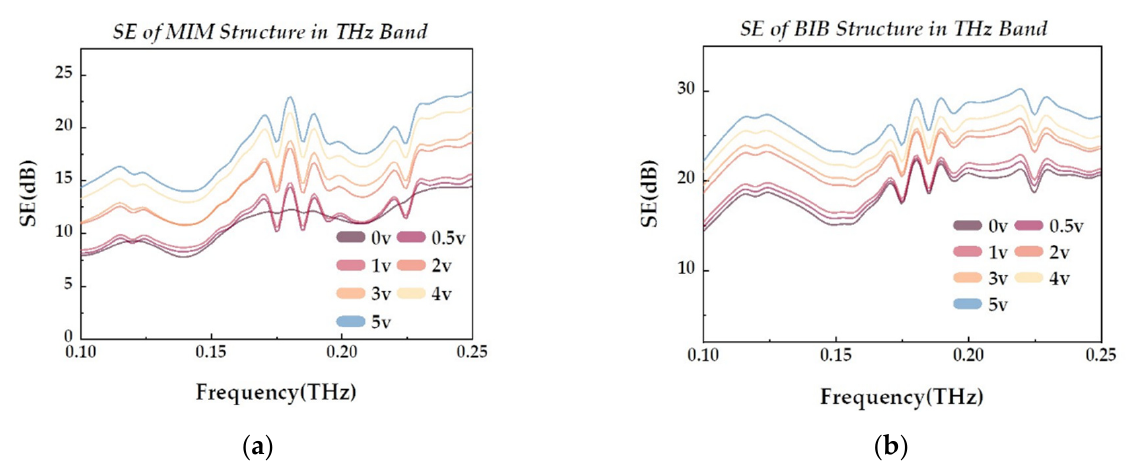
Figure 12. Shielding effectiveness of ( a ) the MIM and ( b ) BIB structures under different voltages in THz band.